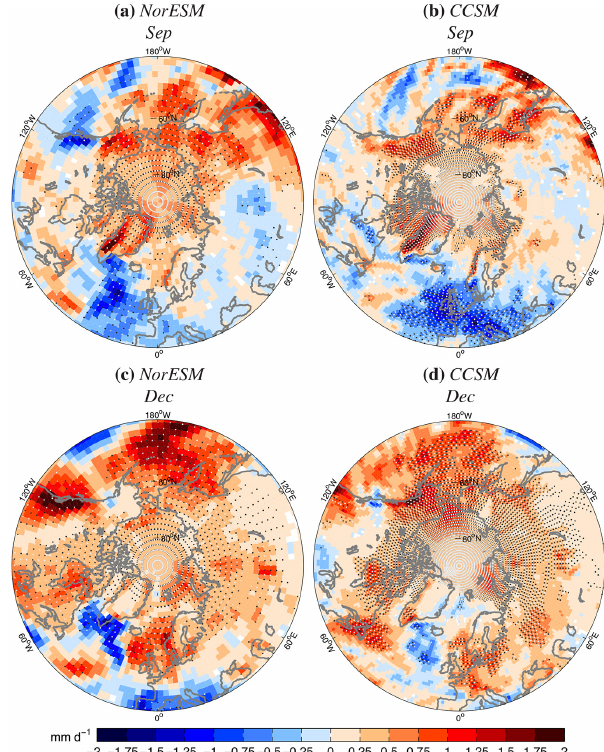
Figure 13. Changes in precipitation averages for September (up- per row) and December (lower row) 2074–2100 compared to 1979– 2005 following the RCP8.5 scenario in (a, c) NorESM and (b, d) CCSM. Alternating black and white dots mark regions of sig- nificant change at a 95% confidence